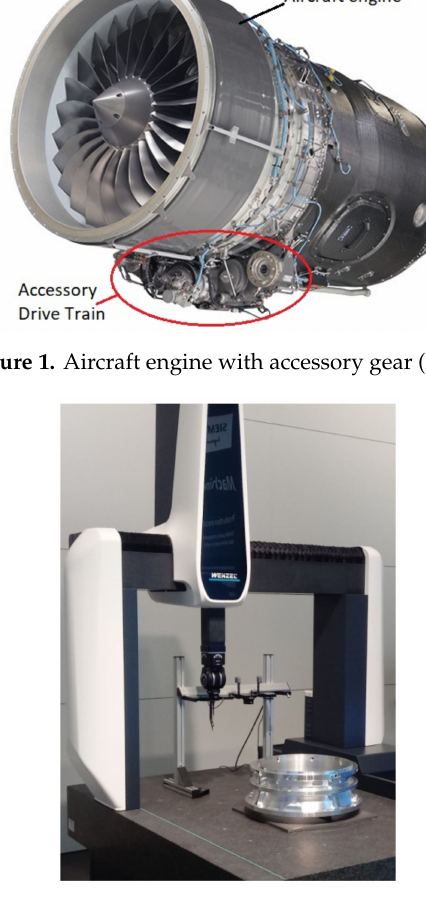
Figure 2. Coordinate Measuring Machine